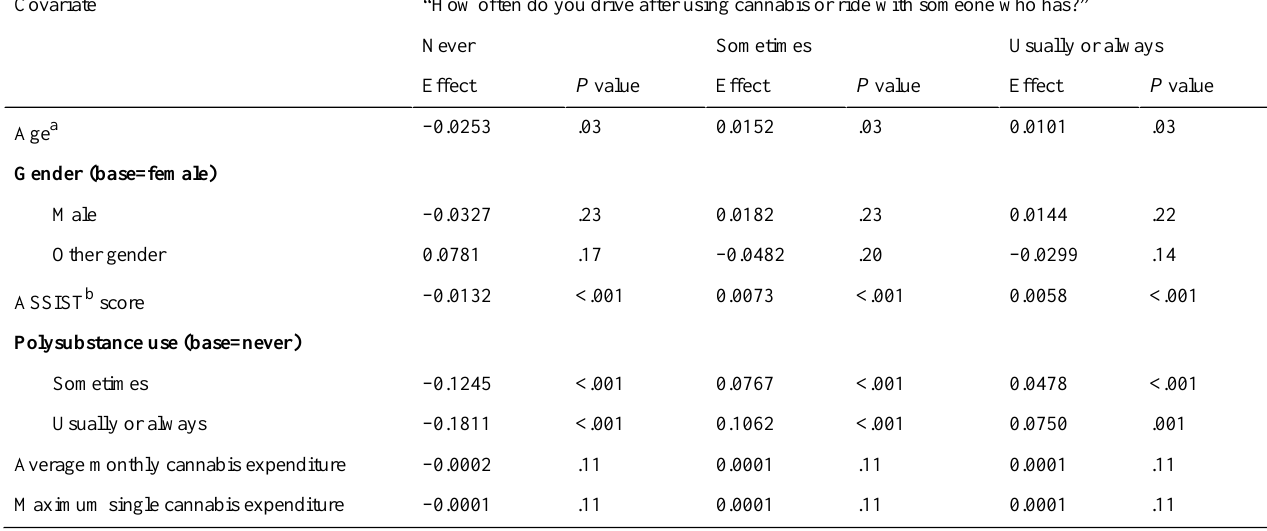
“How often do you drive after using cannabis or ride with someone who has?”Covariate